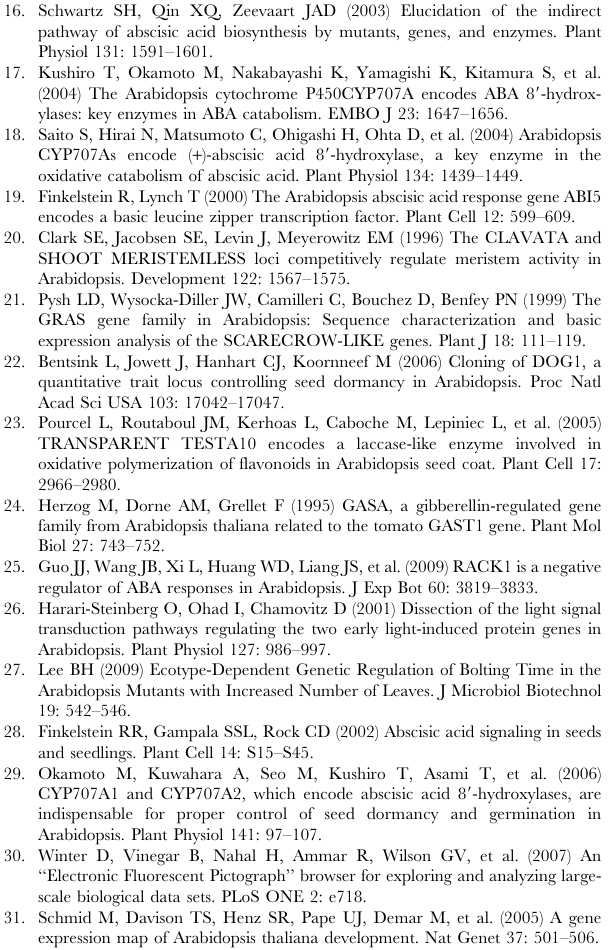
Table S1 Probes differentially expressed in amp1-1 and/or in amp1-21 . Table S2 Probes differentially expressed in amp1-1 . (XLS)